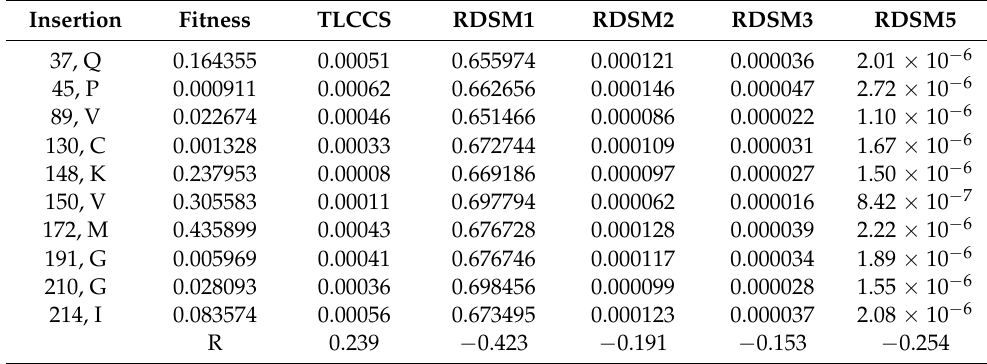
Table 2. Pearson Correlation Coefficient, R, values for TLCCS and RDSM metrics against experimen- tally derived fitness values for InDels TEM-1 β -Lactamase, PDB 1zg6. Insertion = residue